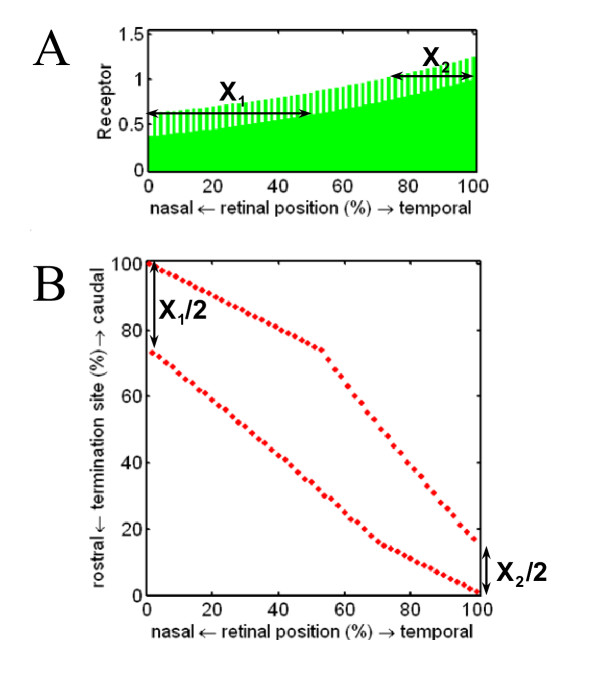
Mapping for heterozygotes in case of no noise. The separation between wild-type and EphA3 knock-in axonal terminals is larger in caudal than in rostral SC, due to inhomogeneity in EphA profile.